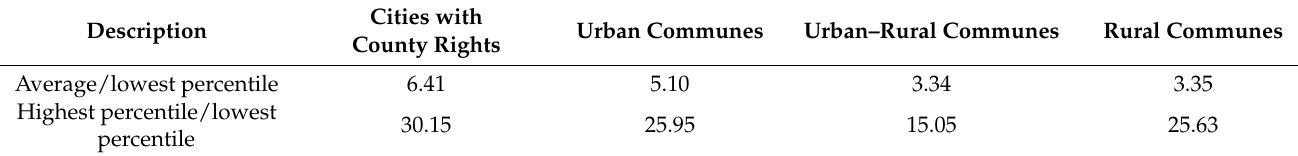
Table 12. Differentiation of the number of the revitalisation area inhabitants in the respective types of the communes. Description